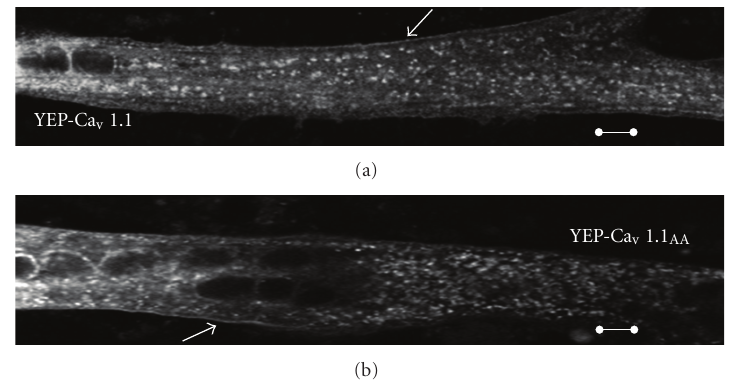
Figure 3: YFP-Ca v 1.1 AA displays similar expression pattern as YFP-Ca v 1.1 in dysgenic myotubes. Confocal images of either YFP-Ca v 1.1 (a) or YFP-Ca v 1.1 AA (b) yellow fluorescence in dysgenic myotubes. Bar 50 μ